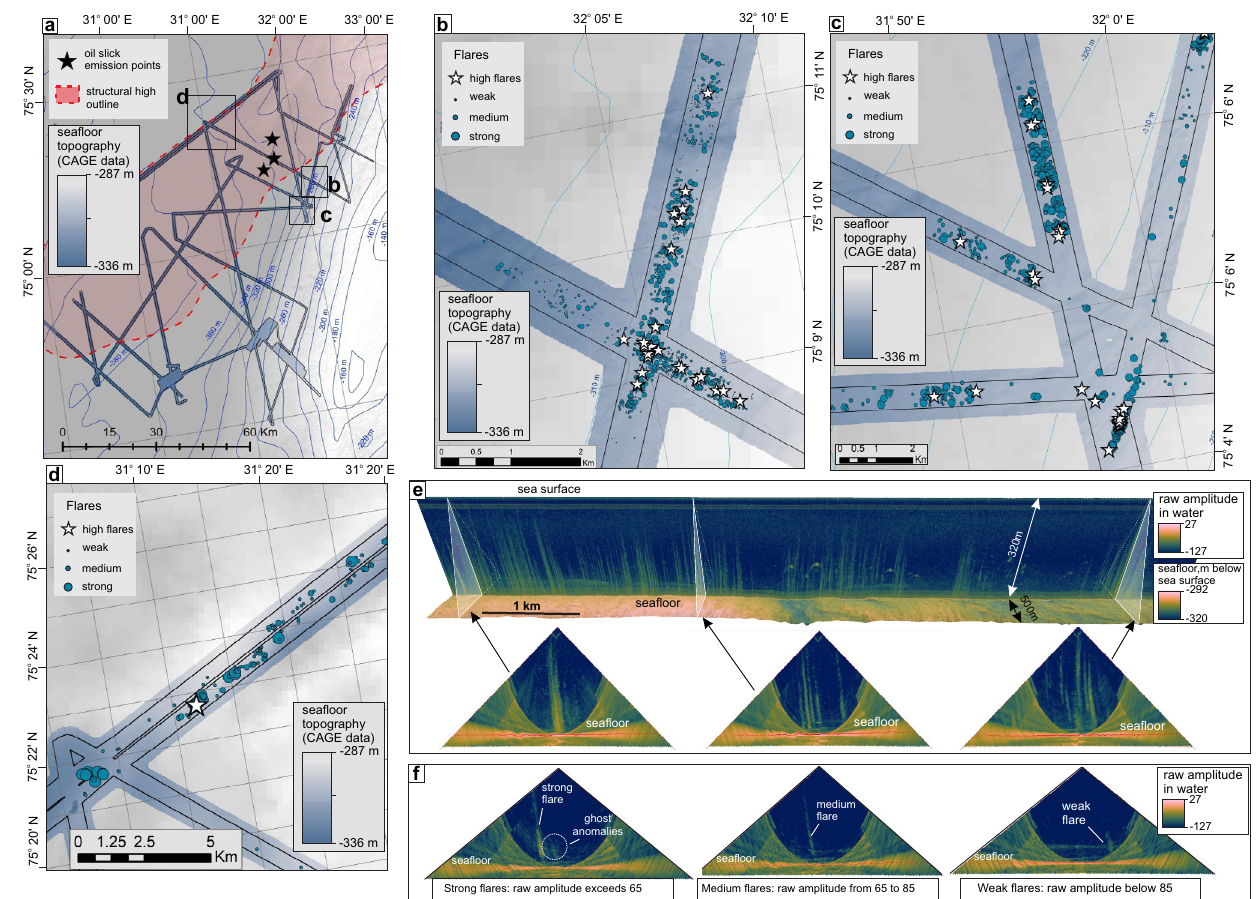
Fig. 3 | Imaging and mapping of the gas release at Sentralbanken high. a – d Locations of gas fl ares at Sentralbanken high. Multibeam bathymetric data is shown in chromatic colour scale. IBCAO V4 bathymetric data 84 is shown in mono- chromatic colour scale. Black lines delineate coverage of data suitablefor gas fl are